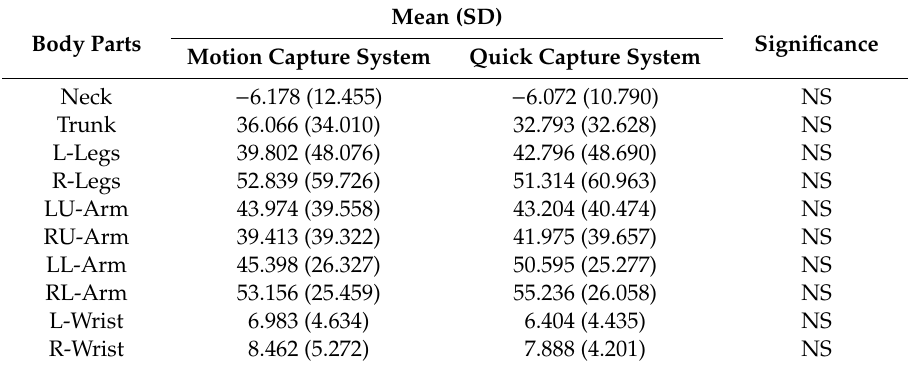
Table 2. Results of t-tests between the motion capture system and the Quick Capture.